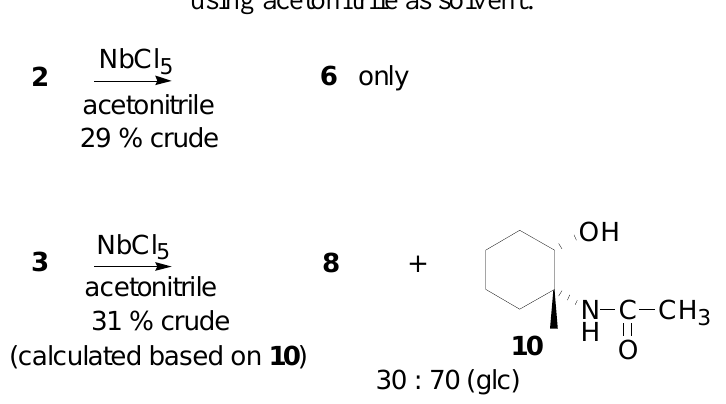
Scheme 2. Results obtained on treatment of epoxides with NbCl using acetonitrile as